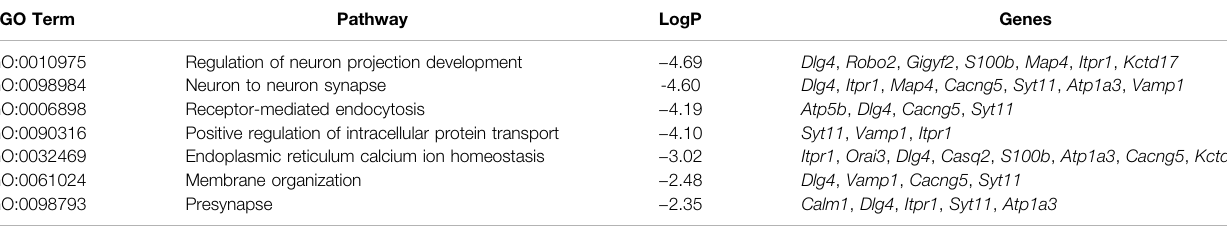
TABLE 2 | Table with downregulated genes identi fi ed under enriched GO biological and cellular process. GO Term Pathway LogP